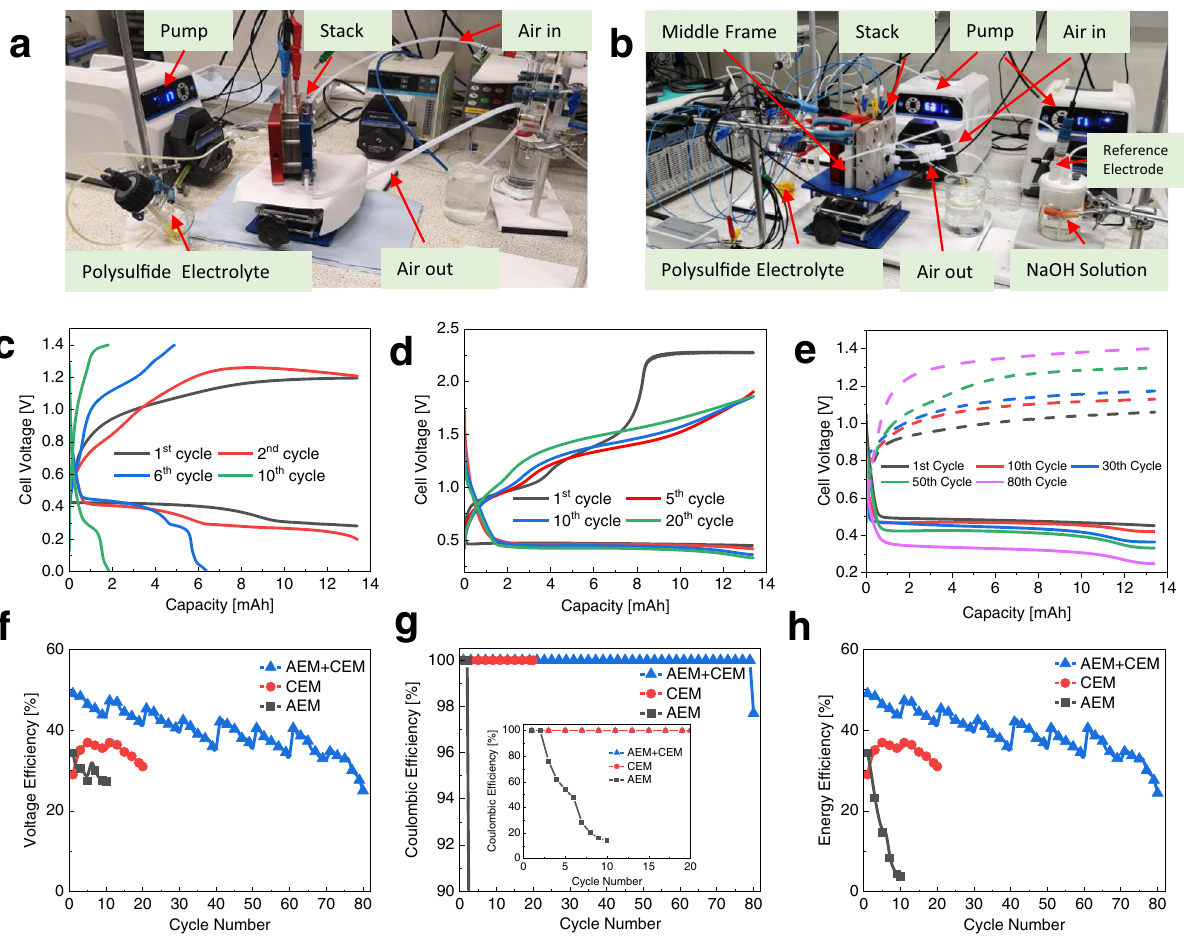
Fig. 4 Charge and discharge cycling of the alkaline PSA RFB. a Experimental setup of single-membrane-structured PSA RFB. b Experimental setup of dual- membrane-structured PSA RFB. c Voltage pro fi le of the PSA RFB with FAA-3-PK-130 AEM over 10 cycles. d Voltage pro fi le of the PSA RFB with Na fi on 117 CEM over 20 cycles. e Voltage pro fi le of the PSA RFB with both FAA-3-PK-130 AEM and Na fi on 117 CEM over 80 cycles. f Voltage ef fi ciencies against cycle number of the PSA RFBs with either single or dual membranes. g Coulombic ef fi ciencies against cycle number of the PSA RFBs with either single or dual membranes. (inset fi gure shows the mini fi ed scale for showing the Coulombic ef fi ciency degradation of single-AEM cell). h Round-trip energy ef fi ciencies against cycle number of the PSA RFBs with either single or dual